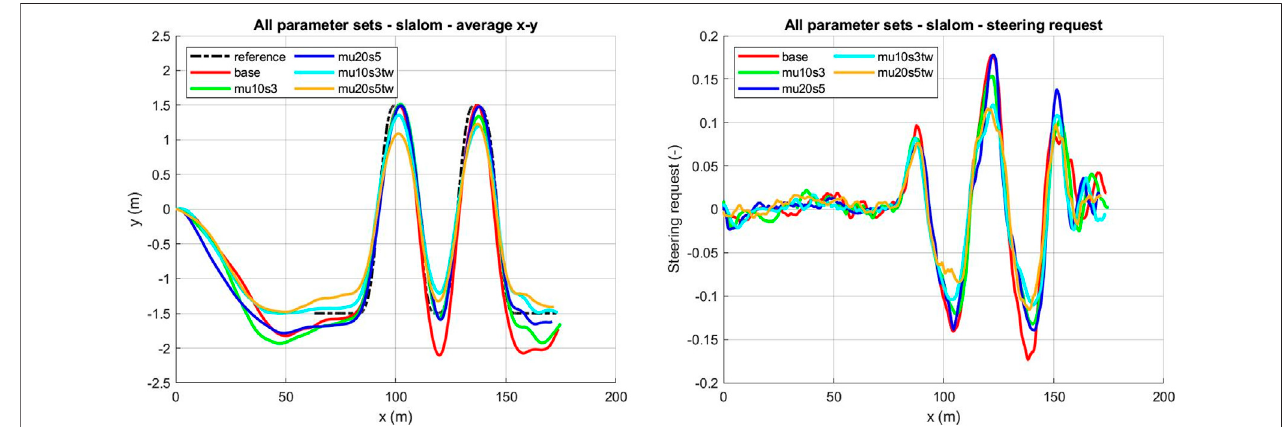
FIGURE 7 | Slalom (HiL). (A) Average position x – y . (B) Average steering request.